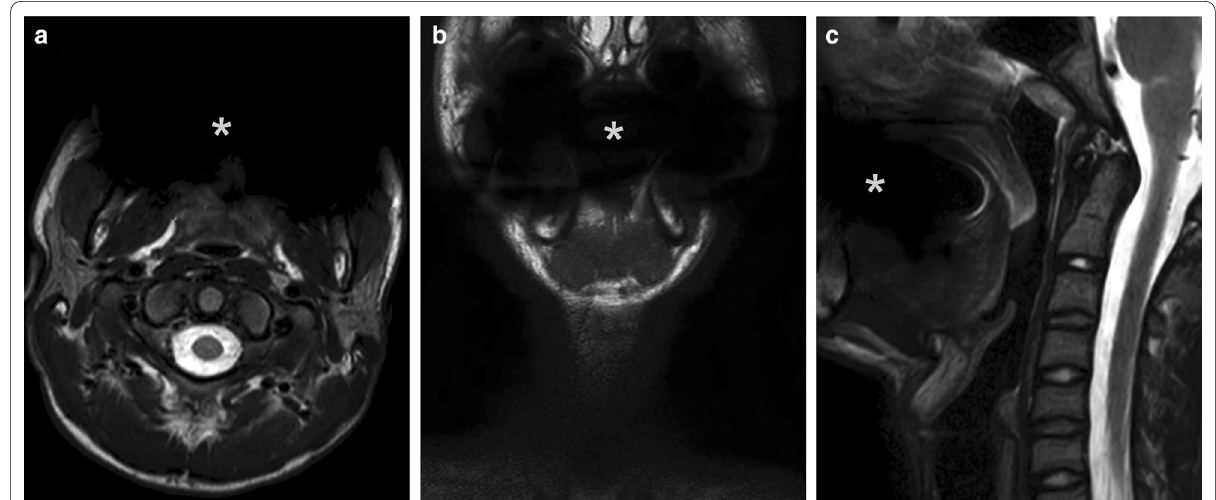
Fig. 26 Braces causing a significant signal loss in the area of the oral cavity (asterisk) in axial ( a ), coronal ( b ), and sagittal ( c ) T2-weighted images